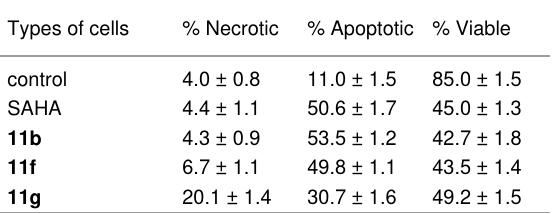
Table 3: Percent of cell death by LDH assay at GI 50 dose after 24 h